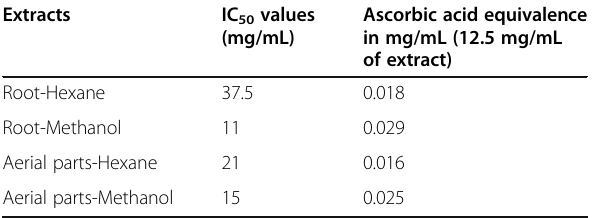
Table 3 IC 50 and ascorbic acid equivalence of the extracts of V . coriaceum in DPPH scavenging